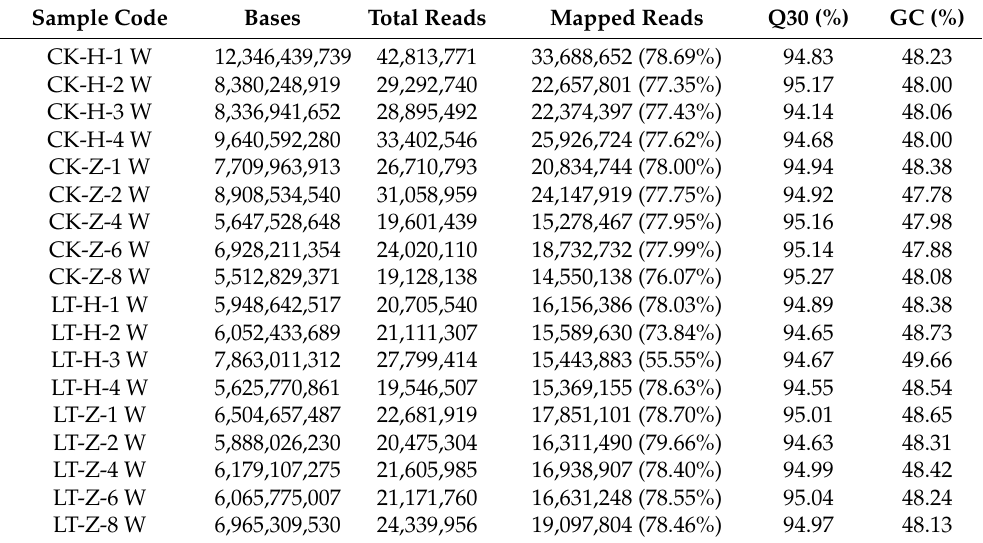
Table 2. Throughput and quality of RNA-seq for 18 libraries Sample Code